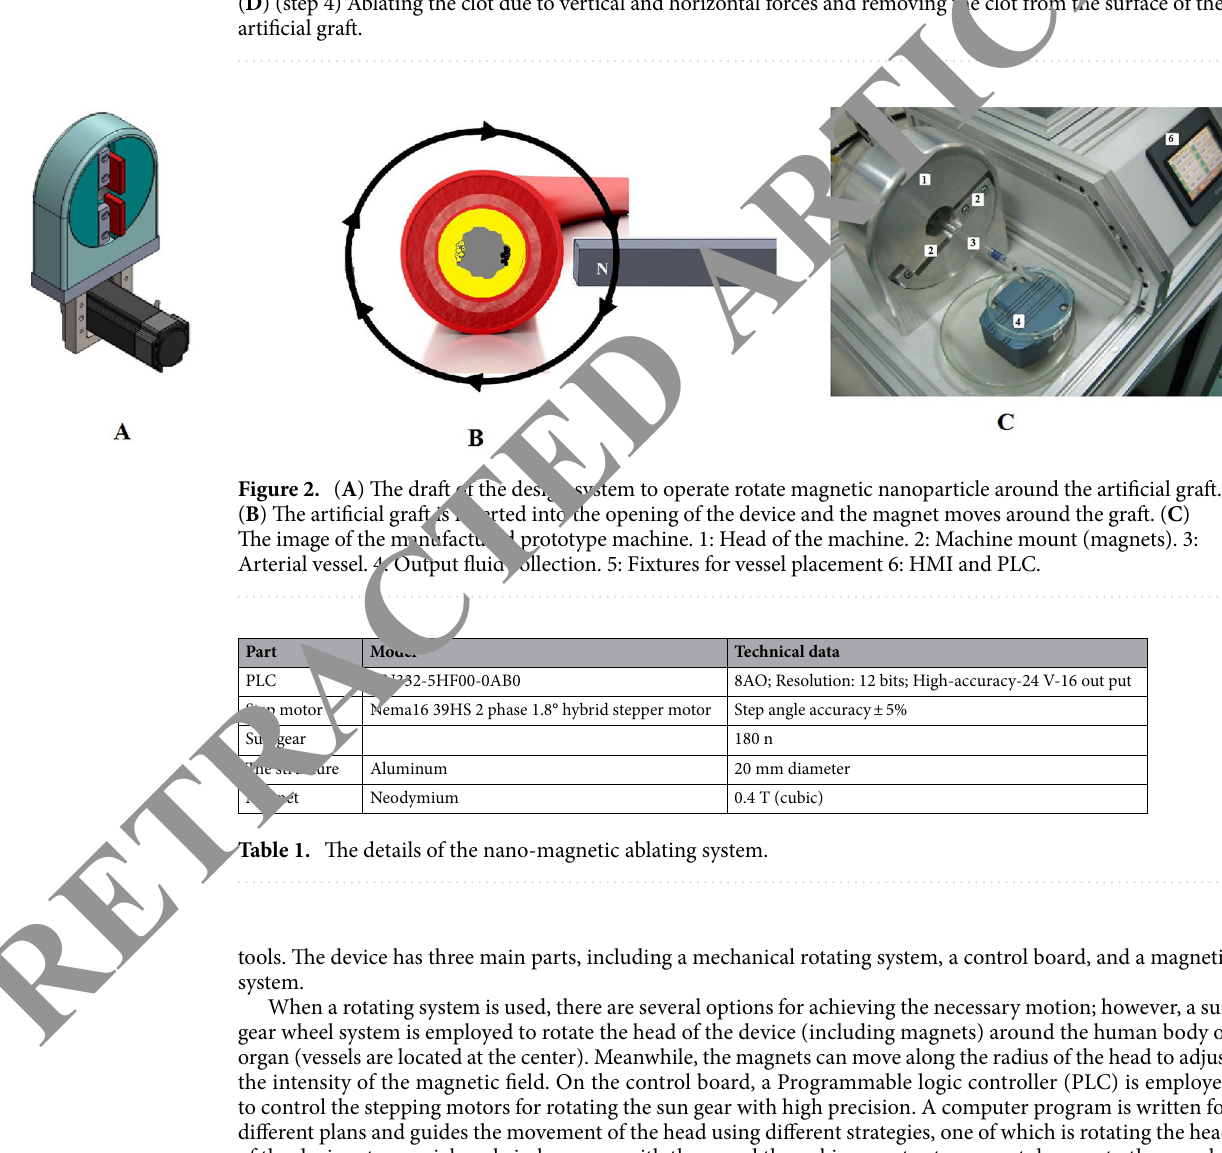
Figure 1. A schematic of nano-magnetic thrombectomy. ( A ) (step 1) Injecting the magnetic nanoparticles into the artificial graft in clot zone. ( B ) (step 2) Rotating of the magnet around the artificial graft. ( C ) (step 3) The magnetic field creates a normal force (F n ) and causes the magnetic particles to be pressed on the surface of the clot, and the driving of the magnetic field leads to moving of nanoparticles (creating a tangential force (F t )).